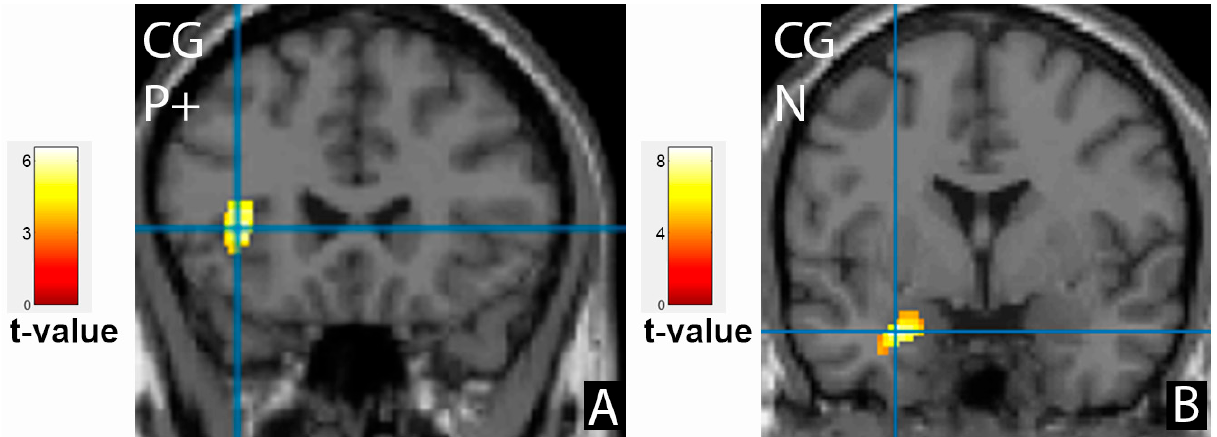
Figure 5. Activation of the left insula ( A ) on demonstration of positive faces (P+) and the left amygdala ( B ) on recognition of neutral emotions (N) in the control group (CG).